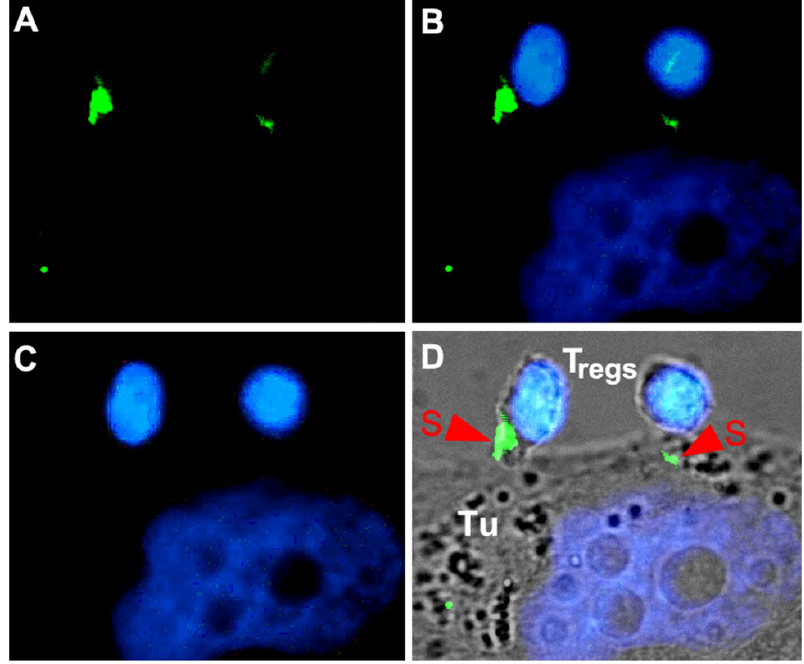
Figure 4. Formation of immune synapse (S)-like structures by cross-linked T tumor (Tu) cells. ( A ) GFP labeled bispecific antibody. ( B ) overlay of DAPI staining ( C ) with GFP signal ( A ). ( D ) overlay of ( B ) with the corresponding phase contrast image.